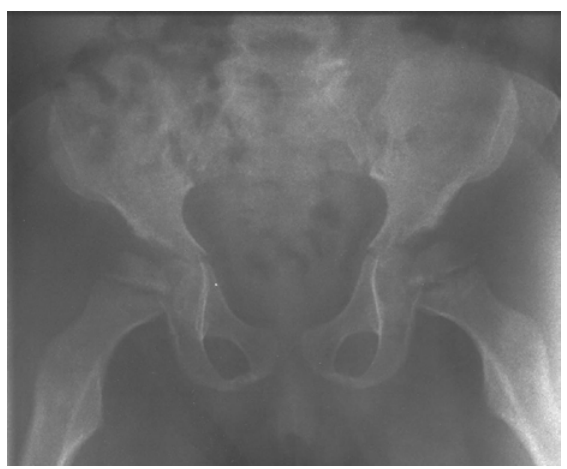
Figure 2. Rapidly progressing 7-year old female MPS VI patient: radiograph of hip showing dysplastic femoral head and hip dysplasia.